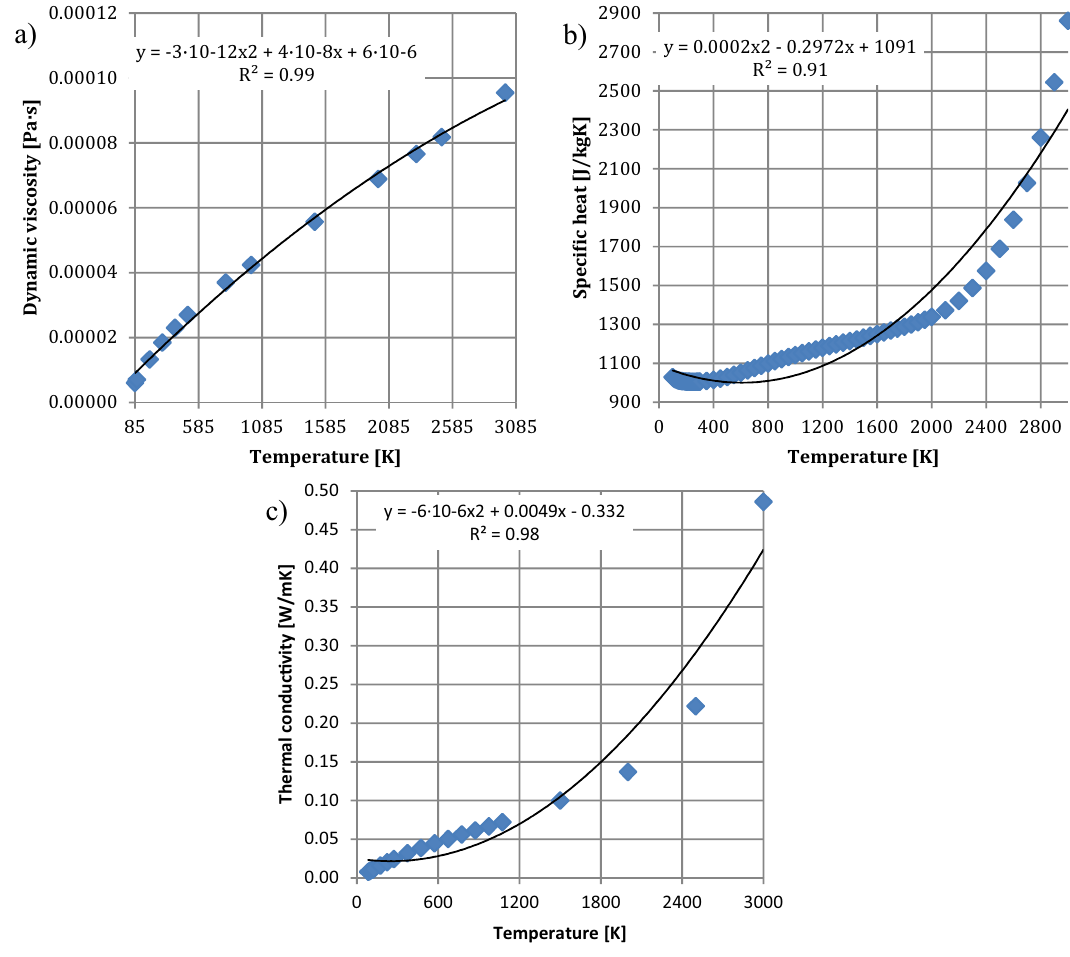
Figure 10. Parameters of air: ( a ) dynamic viscosity, ( b ) specific heat, ( c ) thermal